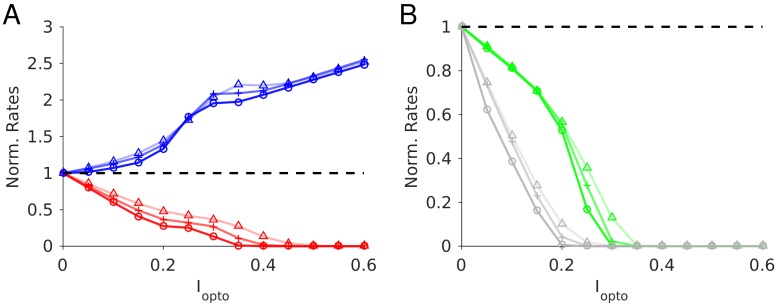
Model 1 with JEE>JEE*.Robustness with respect to change in the average connectivity, K. Triangles: K = 500; cross: K = 1000; circles: K = 2000. Nα = 10000 neurons per population. Baseline firing rates: K = 500: rE = 3.3 Hz, rI = 6.5 Hz, rS = 5.9 Hz, rV = 3.5 Hz; K = 1000: rE = 3.0 Hz, rI = 6.6 Hz, rS = 5.6 Hz,rV = 3.7 Hz; K = 2000: rE = 2.9 Hz, rI = 6.7 Hz, rS = 5.4 Hz, rV = 3.8 Hz. Rates are averaged over 10s. Color code and parameters as in Figure 5.